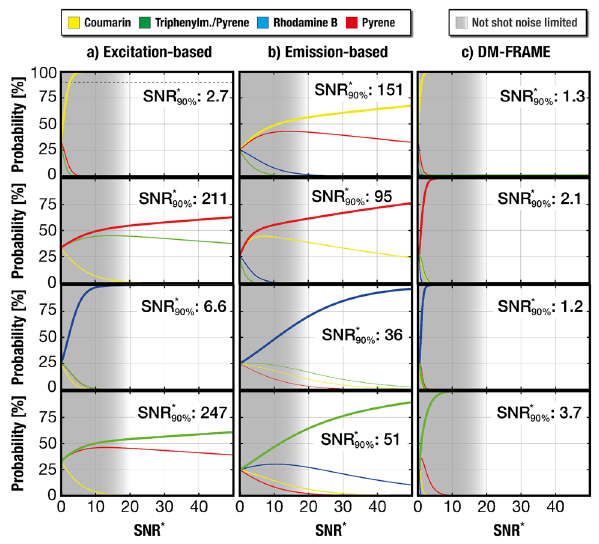
Figure 3. Estimations of the probability of correct fluorophore classification using the three different methods of Fig. 2, modeled for a purely shot noise limited system (indicated by the asterisk above the SNR). The indicated SNR* values correspond to an accurate classification of the fluorophores at a probability of 90%. ( a , b ). Neither the excitation- nor the emission-based detection scheme is able to accurately separate the full set of dyes at SNR* below 150. This susceptibility to noise induced uncertainties could hence be an explanation to the misidentifications observed in the linear unmixing of the corresponding cases in Fig. 2b,c, despite being mathematically solvable. ( c ) The ability of DM-FRAME to sense both emission- and excitation characteristics as well as the increased number of spectral channels it extracts yields a significantly improved species specificity, indicated by the fact the the curves reach 100% at low signal levels. Analysis of the background noise in our data indicates that the shot noise limited approximation holds for our imaging system at an SNR* above ∼ 15 (illustrated by the gray shadowing) and that the shot noise can be approximated by a Gaussian distribution 23 above an SNR* ∼